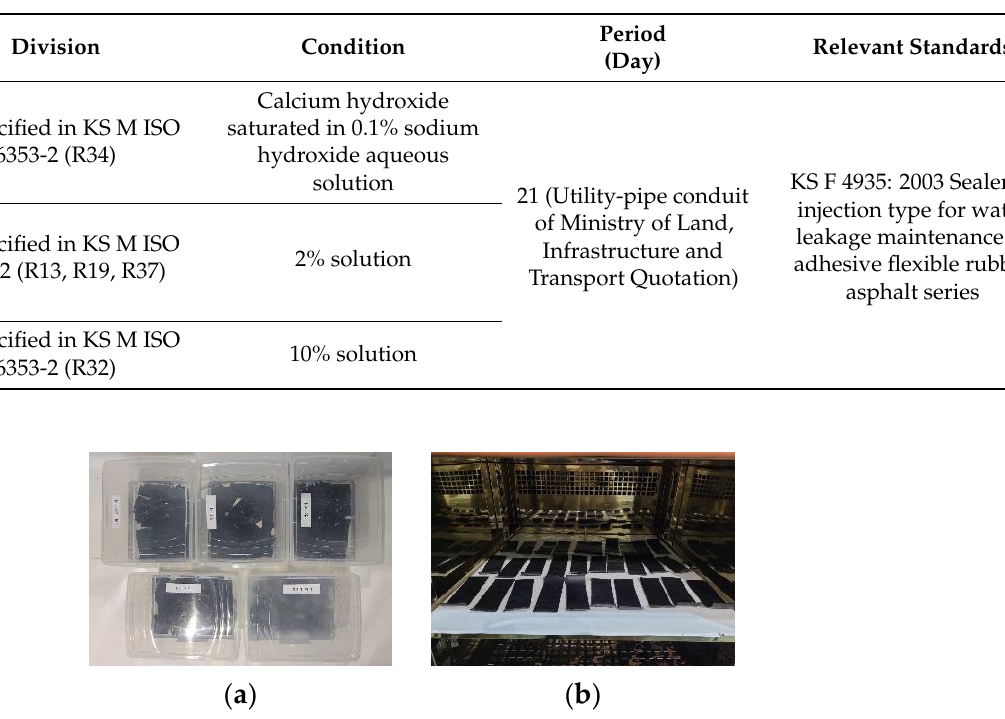
Table 9. Specimen deterioration treatment method.